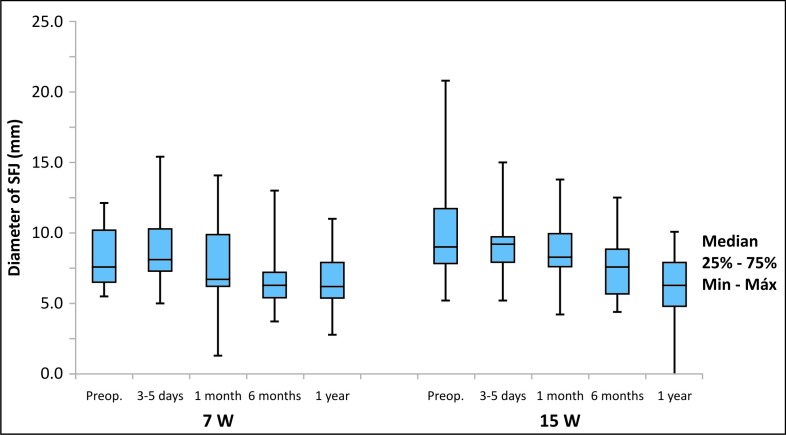
Graph showing results of comparison of the groups considering change in diameter of saphenofemoral junction (SFJ).